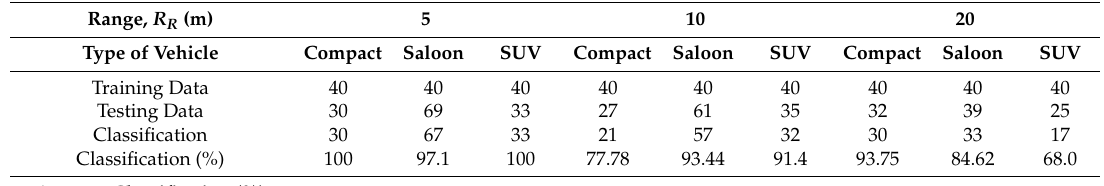
Figure 12. Signal in time at the ADC output for vehicle crossing at different crossing range, R R . Table 5. Vehicle’s category classification performance at different R R . Table 5. Vehicle’s category classification performance at different R R .